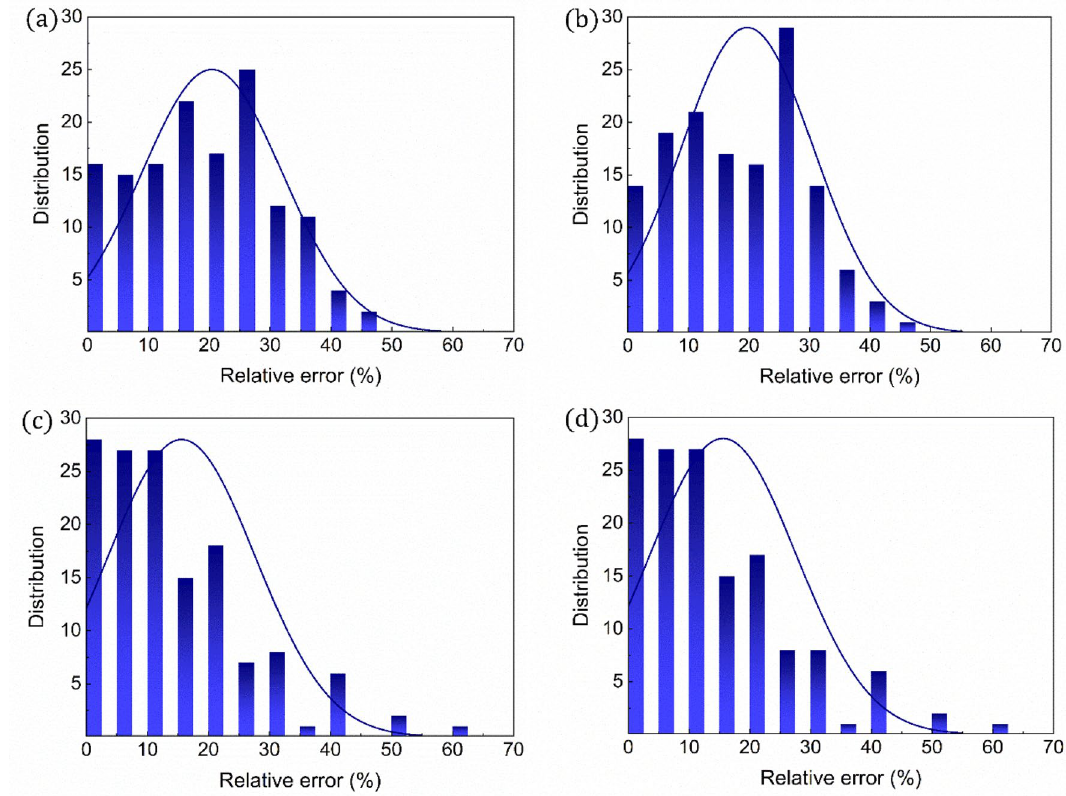
Figure 7. Relative errors for dielectric strength. Errors of the equation-predicted dielectric strengths relative to their experimental values. The coefficients of the equations are parameterized for the equation-based prediction of the experimental values of either ( a ) 30, ( b ) 60, ( c ) 90 or ( d ) all the compounds in Fig. S3 in the Supporting Information. The equations are correlated with polarizability and ionization energy.